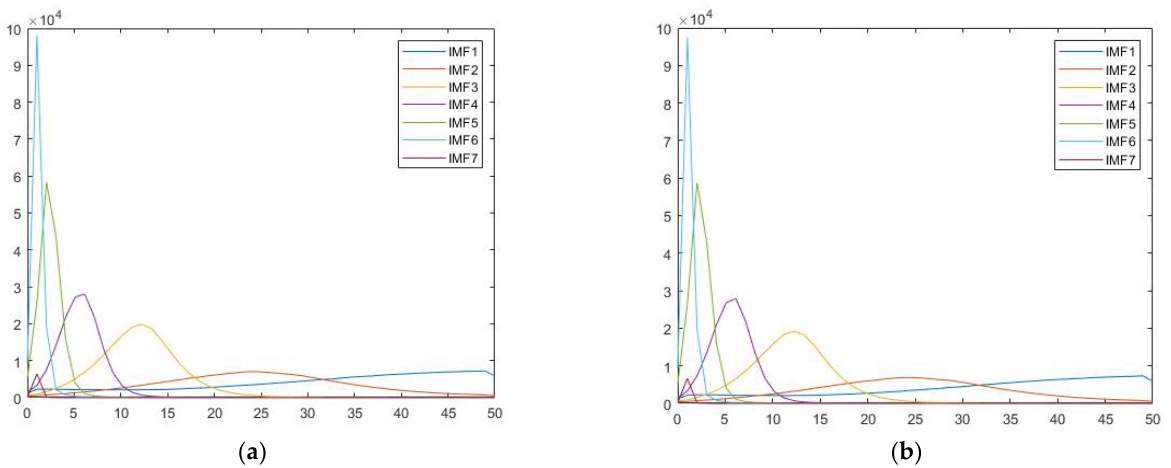
Figure 2. This figure shows the Hilbert spectra for ( a ) famous, ( b ) scrambled face conditions for participant 001 in the dataset. The x -axis is frequency (Hz), and the y -axis is energy